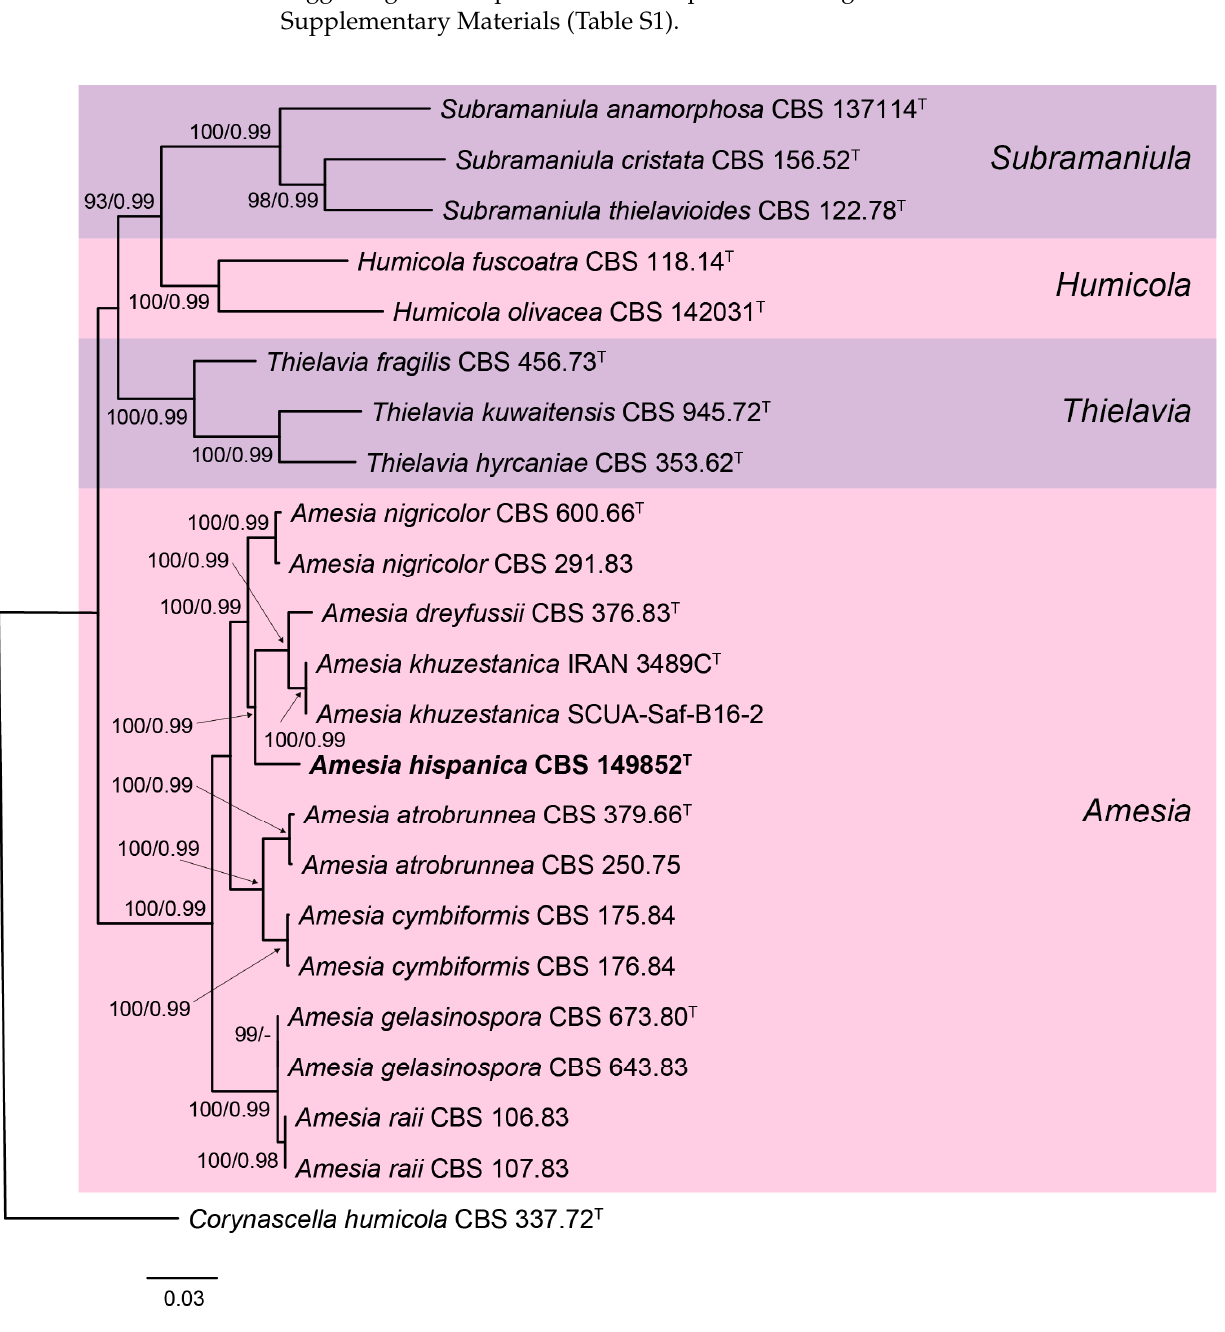
Figure 1. RAxML phylogram obtained from the combined ITS, LSU, rpb2 , and tub2 sequences of our isolate and selected strains belonging to the family Chaetomiaceae. Bootstrap support values ≥ 70/Bayesian posterior probability scores ≥ 0.95 are indicated along branches. Branch lengths are proportional to distance. The novel species is indicated in bold. Ex-type strains of the different species are indicated by T